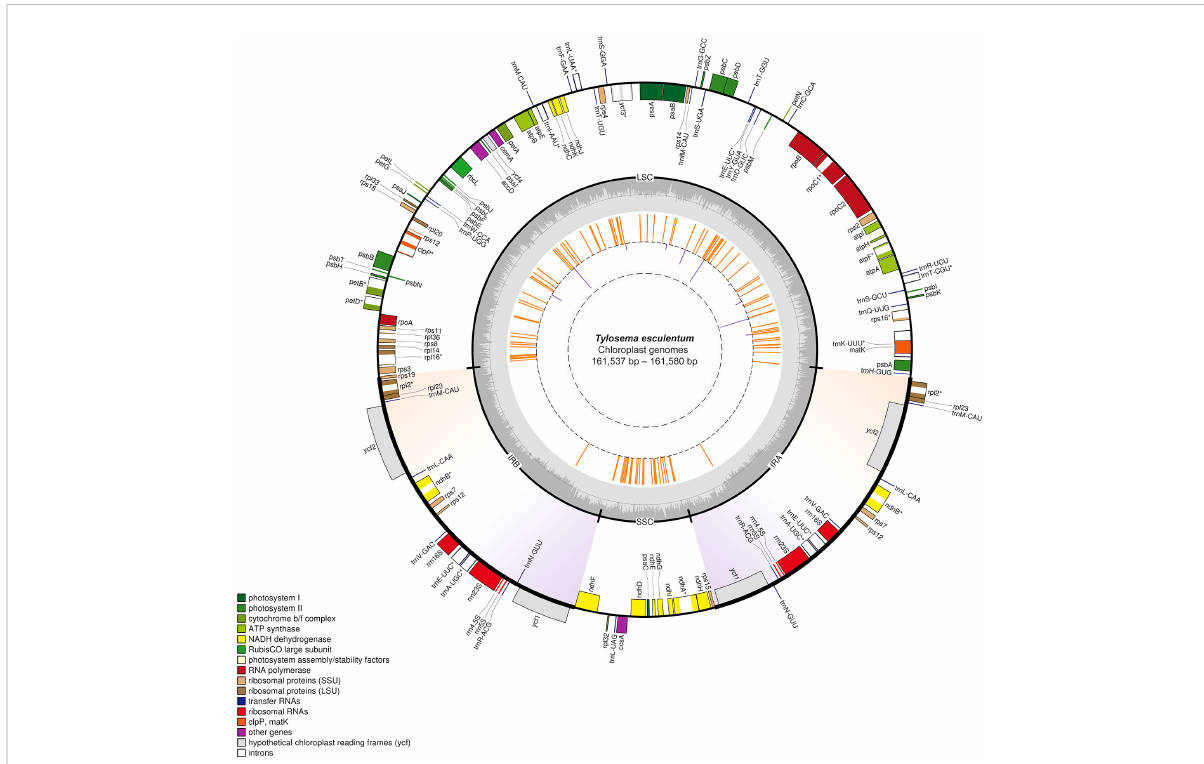
FIGURE 2 Circular gene map of the plastid genomes of T. esculentum drawn by OGDRAW. Genes inside the circle are transcribed clockwise, while genes outside the circle are transcribed counter clockwise. Genes are colored according to their function. Genes with introns are marked with an asterisk. GC content is indicated by the dark grey shading of the inner circle. The two inverted repeats are highlighted by gradient colors. The loci where Type 2 plants and Type 1 plants differ are represented by the orange lines in the inner circle and loci with differences in Type 1 plants from different geographical regions are represented by the purple lines. The length of the lines re fl ects the number of individuals with the alternative